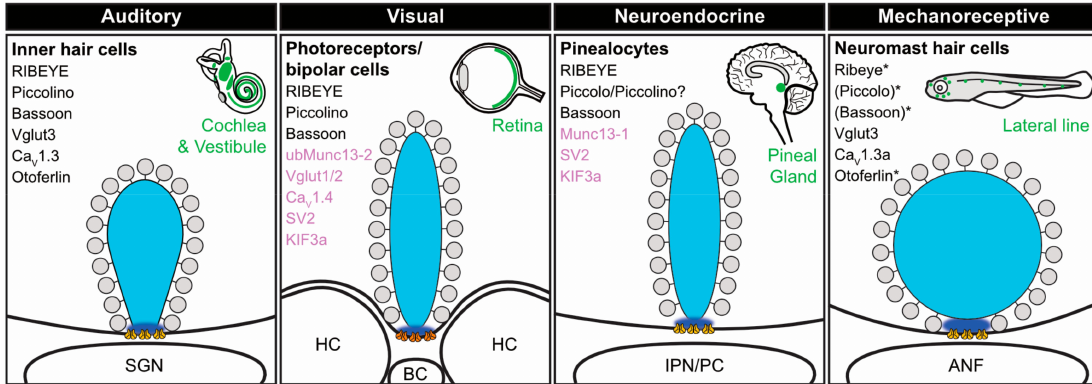
Figure 2. Ribbon synapse morphology and molecular composition di ff er between biological systems. Schematic drawings of stereotypic ribbon shapes from the indicated sensory or neuroendocrine system they are operating in, to illustrate gross morphological and molecular di ff erences: Selected conserved (black) and non-conserved (magenta) ribbon-associated proteins are highlighted in the respective boxes. Insets show the approximate locations of the ribbon-bearing cell populations (green) in a larger context. Please note: Ribbon dimensions are not drawn to absolute scale. Zebrafish gene duplications are highlighted with an *, Piccolo a / b and Bassoon b are expressed on mRNA level (https: // piotrowskilab.shinyapps.io / neuromast_homeostasis_scrnaseq_2018); however, protein localization to the ribbon remains to be demonstrated. ANF, a ff erent nerve fiber; BC, bipolar cell; HC, horizontal cell; IPN, intrapineal neuron; PC, pinealocyte; SGN, spiral ganglion